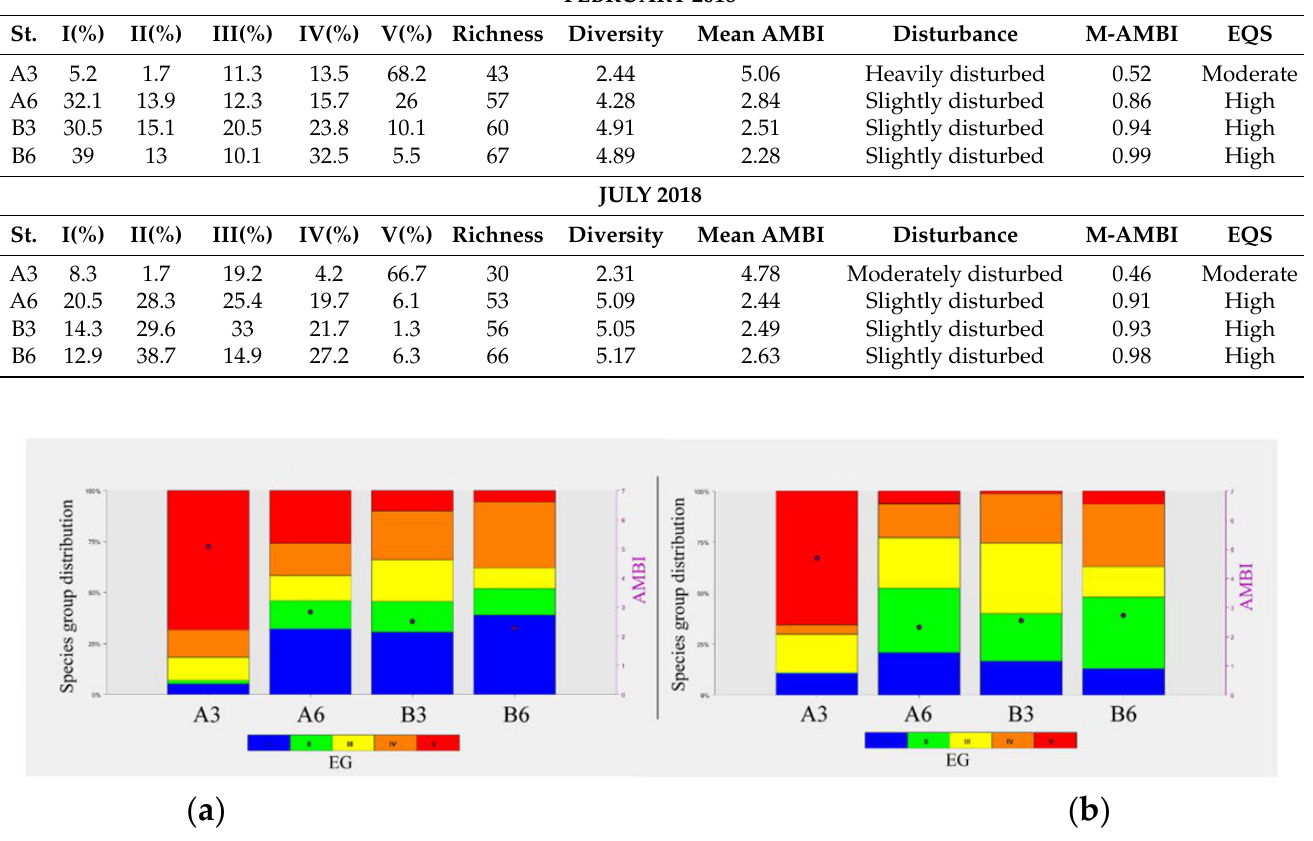
Figure 6. AMBI values and representation of the species group distribution at the different stations in February 2018 ( a ) and July 2018 ( b ) campaigns. A similar trend was enhanced by the M-AMBI index, although the values indicated a relatively better situation at most of the stations (Figure